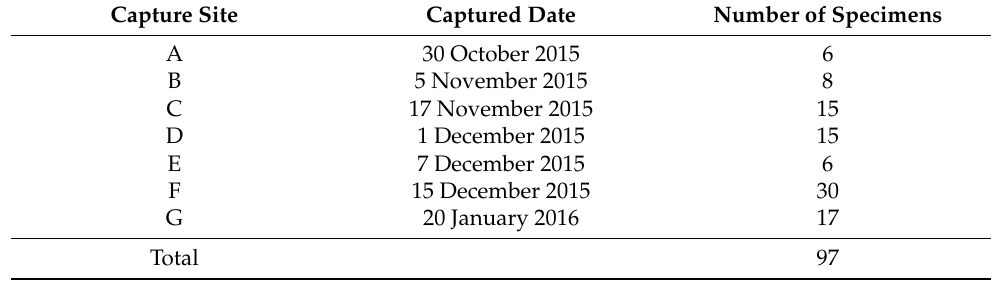
Table 1. The capture sites and dates, and number of specimens of the pufferfish, Takifugu flavipterus . Capture Site